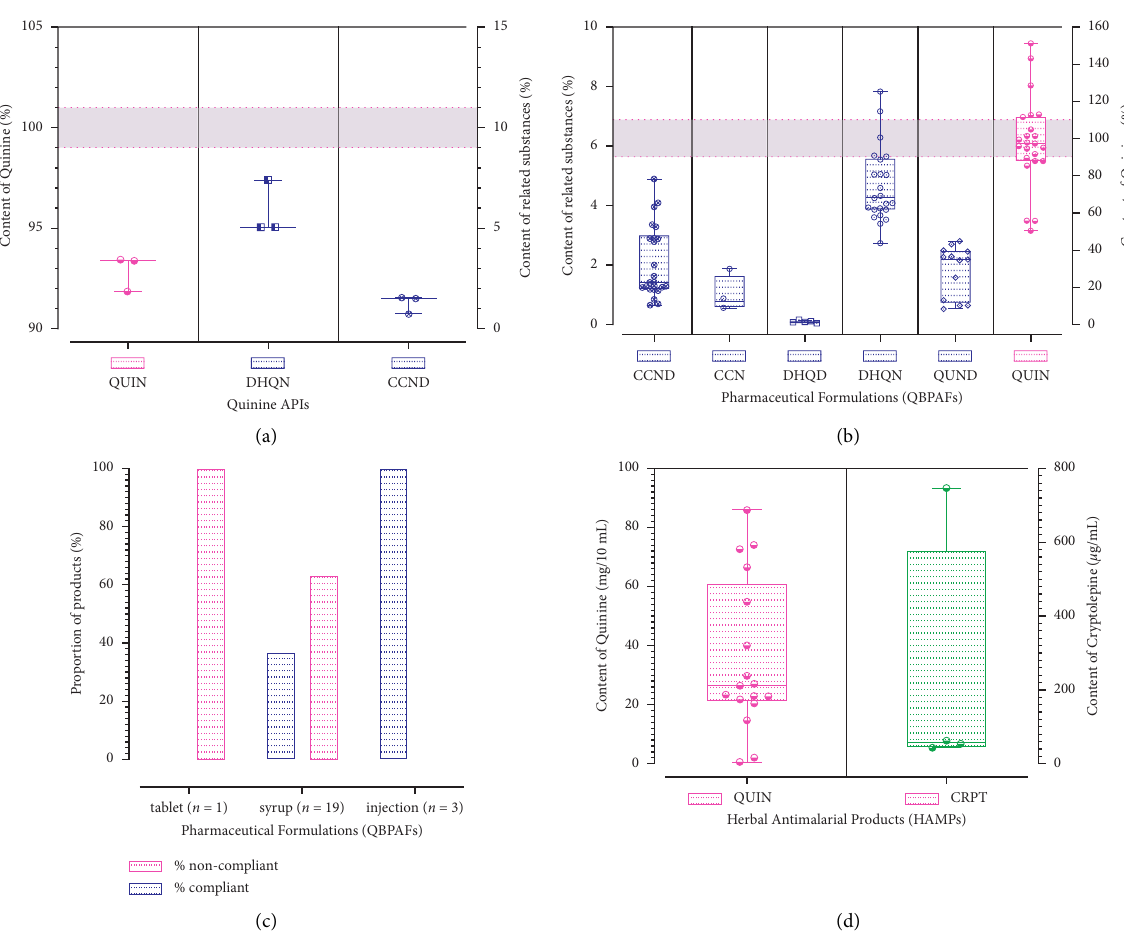
Figure 3: Analyses of contents in the herbal and pharmaceutical antimalarial formulations. (a) Content assays of quinine APIs ( n � 3). Quinine contents (Ref: left y -axis) and related substances (Ref: right y -axis) detected. None of the APIs contained the right amount of quinine (indicated as the highlighted region in the graph) for product manufacture. (b) Contents of quinine (Ref: right y -axis) and its related alkaloidal substances (Ref: left y -axis) in the orthodox products. The highlighted region (Ref: right y -axis) indicates the range of contents deemed acceptable for quinine content. (c) Proportions of QBPAFs that either complied or did not comply with the acceptance criteria on quinine content. (d) Content assays of analytes in the herbal products. Quinine (Ref: left y -axis) and cryptolepine (Ref: right y -axis) constitute the main antimalarial alkaloids detected in the herbal products. Quinine (QUIN) and cryptolepine (CRPT) constitute the main APIs in the samples analyzed, while the related substances included cinchonidine (CCND), cinchonine (CCN), dihydroquinidine (DHQD), dihydroquinine (DHQN), and quinidine